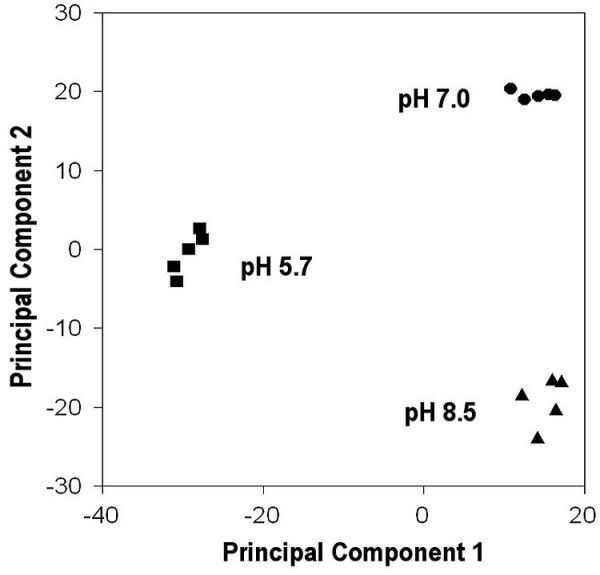
Principal components analysis. The gene expression profiles of the arrays were visualized in two-dimensional Euclidian space, by using BRB ArrayTools software. The horizontal axis represents the first principal component of variation, that is, a projection of the array data representing the maximal variance among them. The vertical axis represents the second principal component of variation. The pH 5.7, squares; pH 7.0, circles; pH 8.5, triangles.